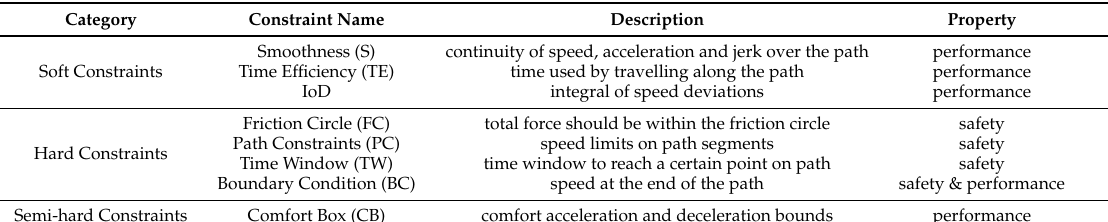
Table 1. Constraints for speed